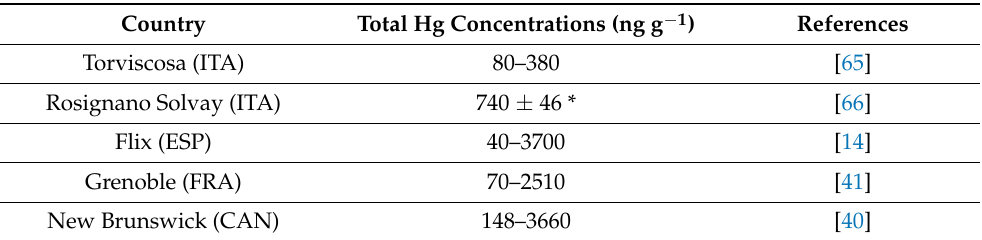
Table 3. Total Hg concentrations (ng g − 1 ) measured in lichens sampled in different sites contaminated by chlor-alkali plant industrial activity. * Mean ±